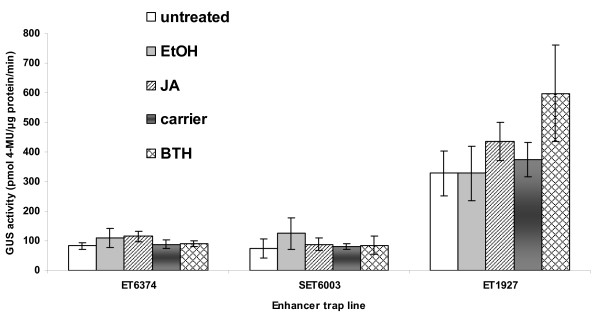
GUS quantitative assays of enhancer trap lines with insertions into two NBS-LRR-encoding and one related gene. GUS expression levels of each enhancer trap line untreated or five days after application of JA or BTH. Treatments with ethanol (EtOH) or BTH carrier (carrier) were used as controls. Average GUS expression levels and standard deviations were based on three biological replicates. The background levels of GUS activity in untreated Col-0 plants were below 20 pmol 4-MU/μg protein/min.